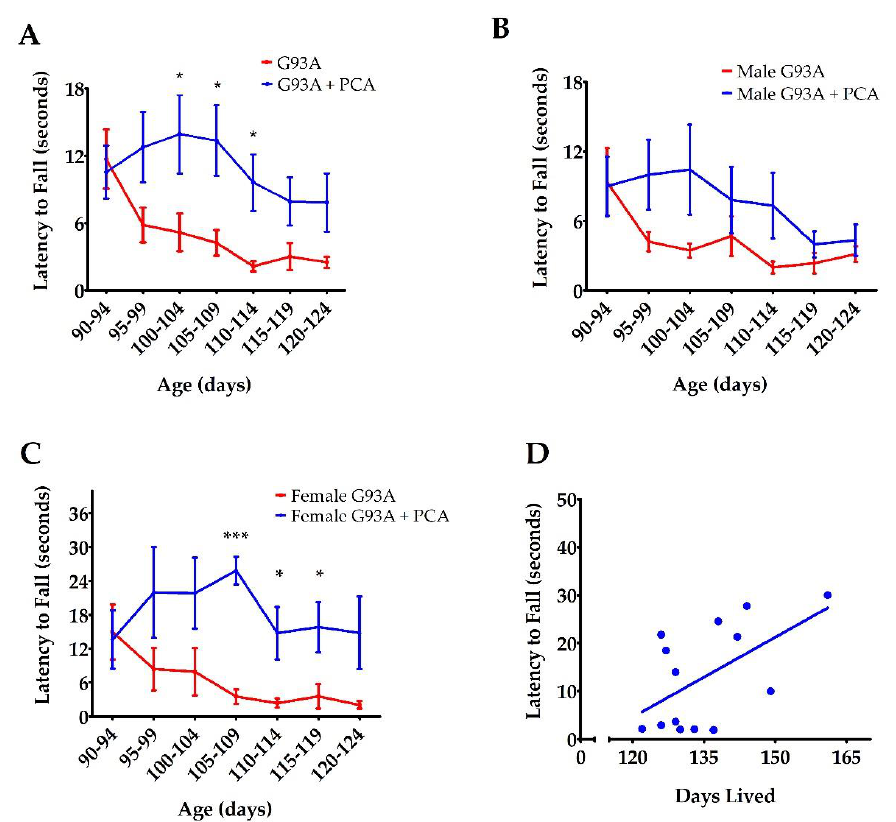
Figure 2. PCA treatment improves grip strength as assessed by PaGE in the hSOD1 G93A mouse model of ALS. ( A ) PaGE testing of hSOD1 G93A mice (untreated or treated with 100 mg/kg PCA) beginning at disease onset. PaGE testing was performed twice a week beginning at 90 days of age and is expressed as latency to fall. PaGE data are expressed as the mean ± SEM for each time point; n = 15 mice per group. * indicates p < 0.05 in comparison to untreated hSOD1 G93A littermate controls. All data were analyzed using an unpaired t -test at each time point. ( B ) PaGE testing of male hSOD1 G93A mice (untreated or treated with 100 mg/kg PCA) beginning at disease onset. PaGE data are expressed as the mean ± SEM for each time point; n = 9 mice per group. All data were analyzed using an unpaired t -test at each time point. ( C ) PaGE testing of female hSOD1 G93A mice (untreated or treated with 100 mg/kg PCA) beginning at disease onset. PaGE data are expressed as the mean ± SEM for each time point; n = 6 mice per group. All data were analyzed using an unpaired t -test at each time point. * indicates p < 0.05 in comparison to untreated hSOD1 G93A littermate controls. *** indicates p < 0.001 in comparison to untreated hSOD1 G93A littermate controls. ( D ) Increased average PaGE latency to fall between 100 and 114 days of age is significantly correlated with longer survival of 100 mg/kg PCA- treated hSOD1 G93A mice. PaGE data from 100 – 114 days of age are expressed as the mean for each mouse; n = 14 mice. All data were analyzed using a Pearson correlation ( r = 0.558, p < 0.05). For further motor function analysis, rotarod testing was performed once a week beginning at disease onset until end stage of disease. This behavioral assay also showed an impressive enhancement in the motor function of PCA-treated hSOD1 G93A mice when compared to untreated hSOD1 G93A littermates. Administration of 100 mg/kg PCA beginning at disease onset significantly but transiently increased the latency to fall as measured by rotarod testing at 97 and 104 days of age when compared to the untreated hSOD1 G93A littermate control mice ( p < 0.001, Figure 3A). The results of these behavioral tests indicate that oral administration of PCA beginning at disease onset